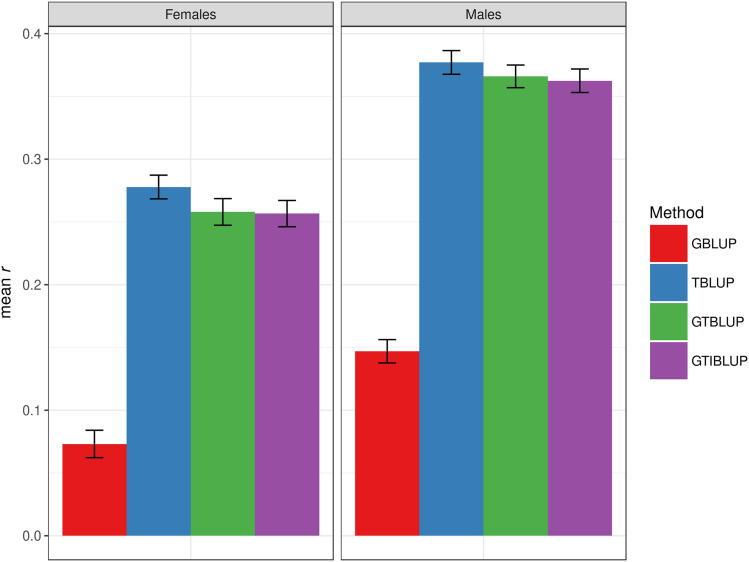
Prediction accuracy for starvation resistance, measured as mean r (on the y-axis) in the test set, obtained by GBLUP, TBLUP, GTBLUP, and GTIBLUP. The bars represent the standard error of the mean. The left panel represents females, and the right panel represents males.